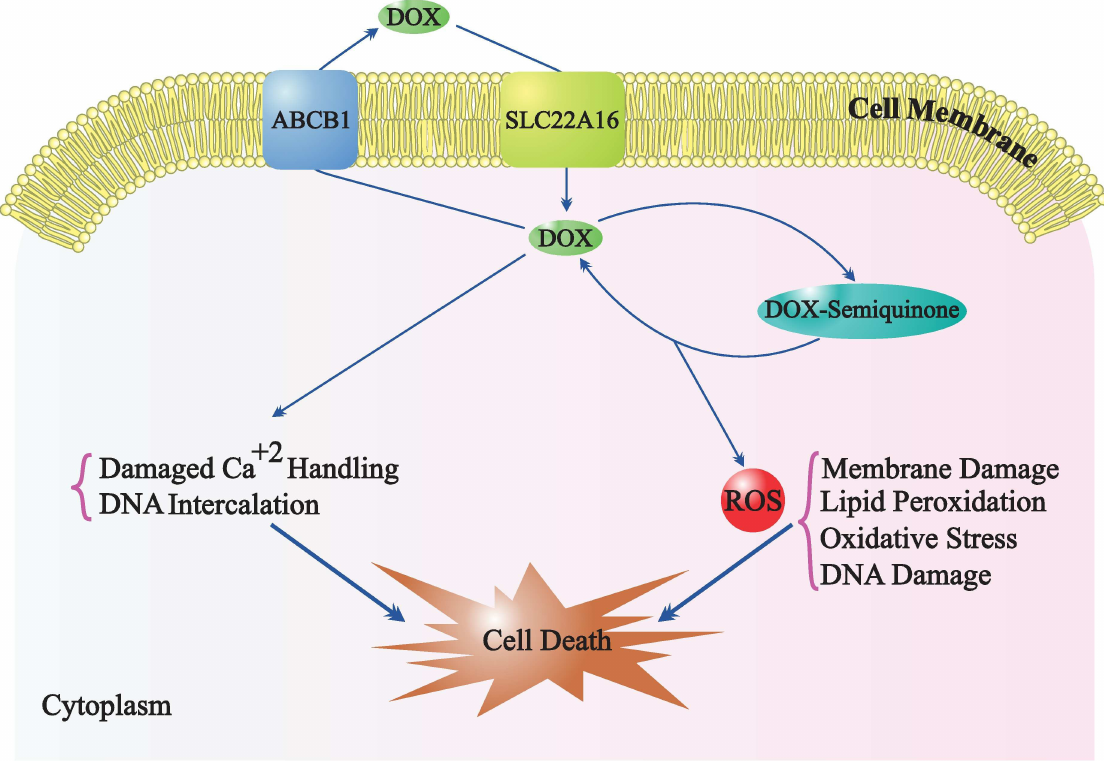
Fig 1. Transport and mechanism of action of